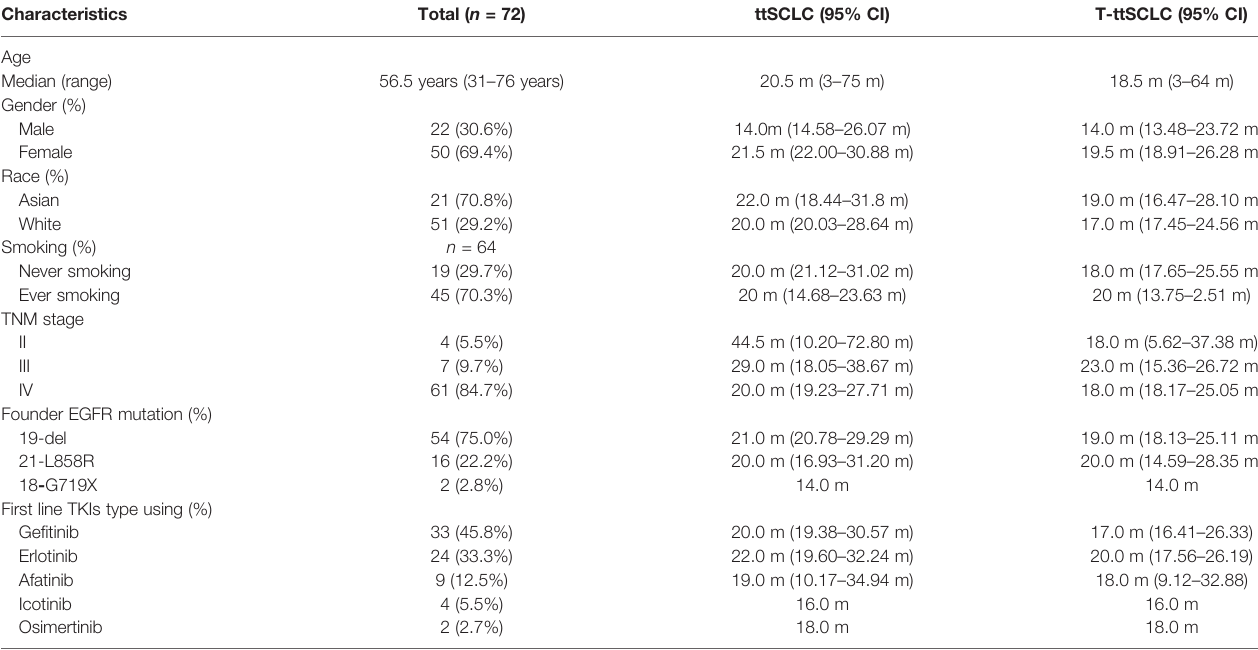
TABLE 1 | Clinical characteristics of patients with advanced EGFR-mutated LADC transforming to SCLC.